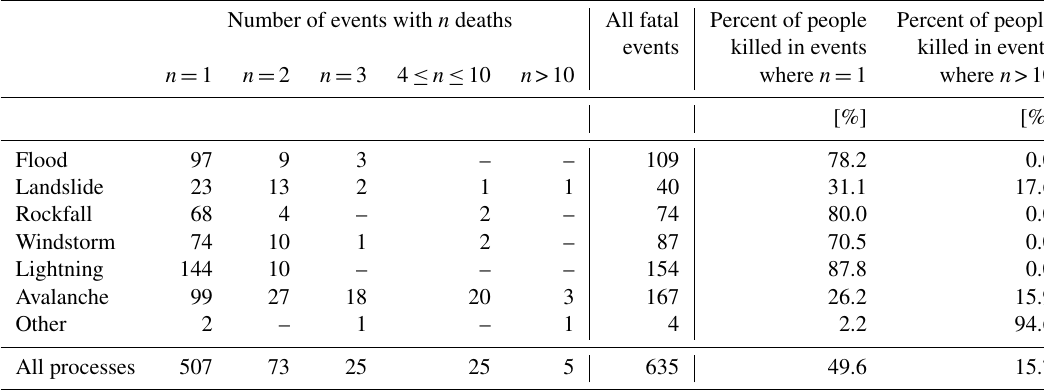
Table 4. Fatal natural hazard events in Switzerland (1946–2015) classified by number of victims. The last two columns indicate the percentage of people that died in single fatality events (second to last column) and in events with more than 10 deaths (last column); note that in the bottom row 100% corresponds to 1023 deaths for all process